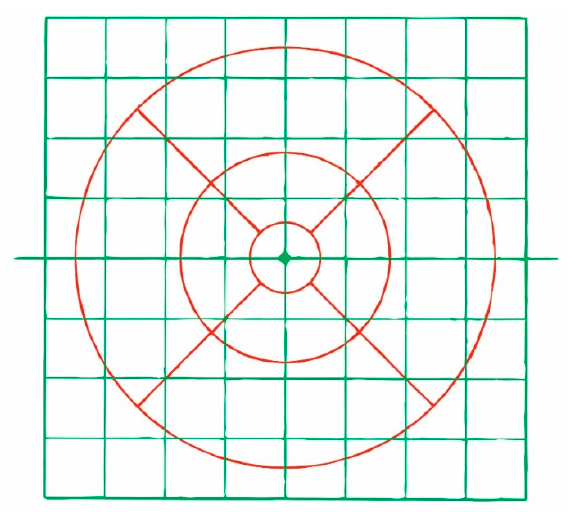
Figure 11. Superposition in real size of the 8 × 8 PPA (green) and ETDRS grid (red).